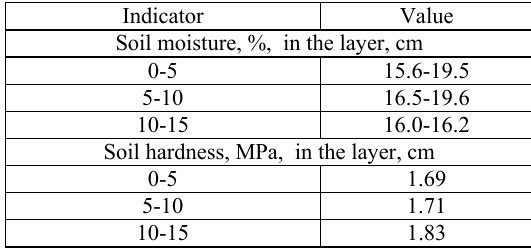
Table 3. Physical and mechanical properties of the soil